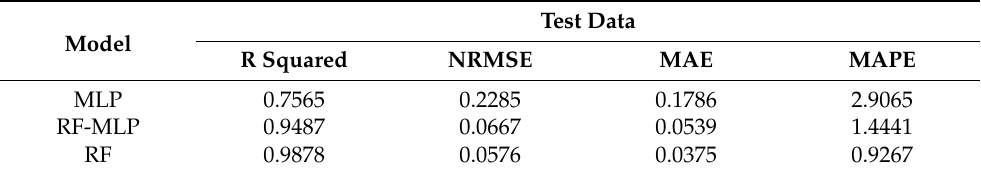
Table 2. Prediction accuracy of RF, MLP, and